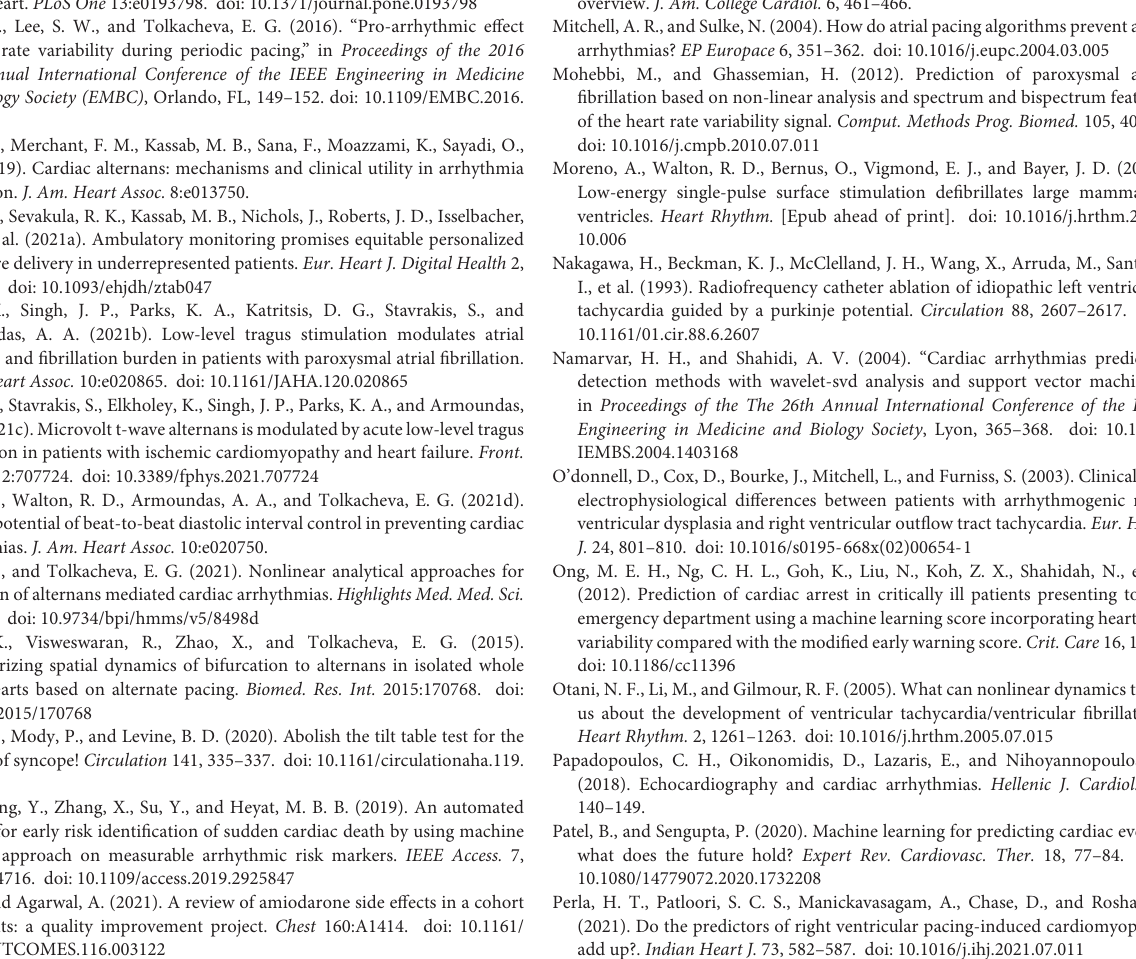
table test. Zhonghua Xin Xue Guan Bing Za Zhi 38, 805–808. Maury, P., Sacher, F., Gourraud, J.-B., Pasquié, J.-L., Raczka, F., Bongard, V., et al. (2015). Increased tpeak-tend interval is highly and independently related to arrhythmic events in brugada syndrome. Heart Rhythm. 12, 2469–2476. doi: